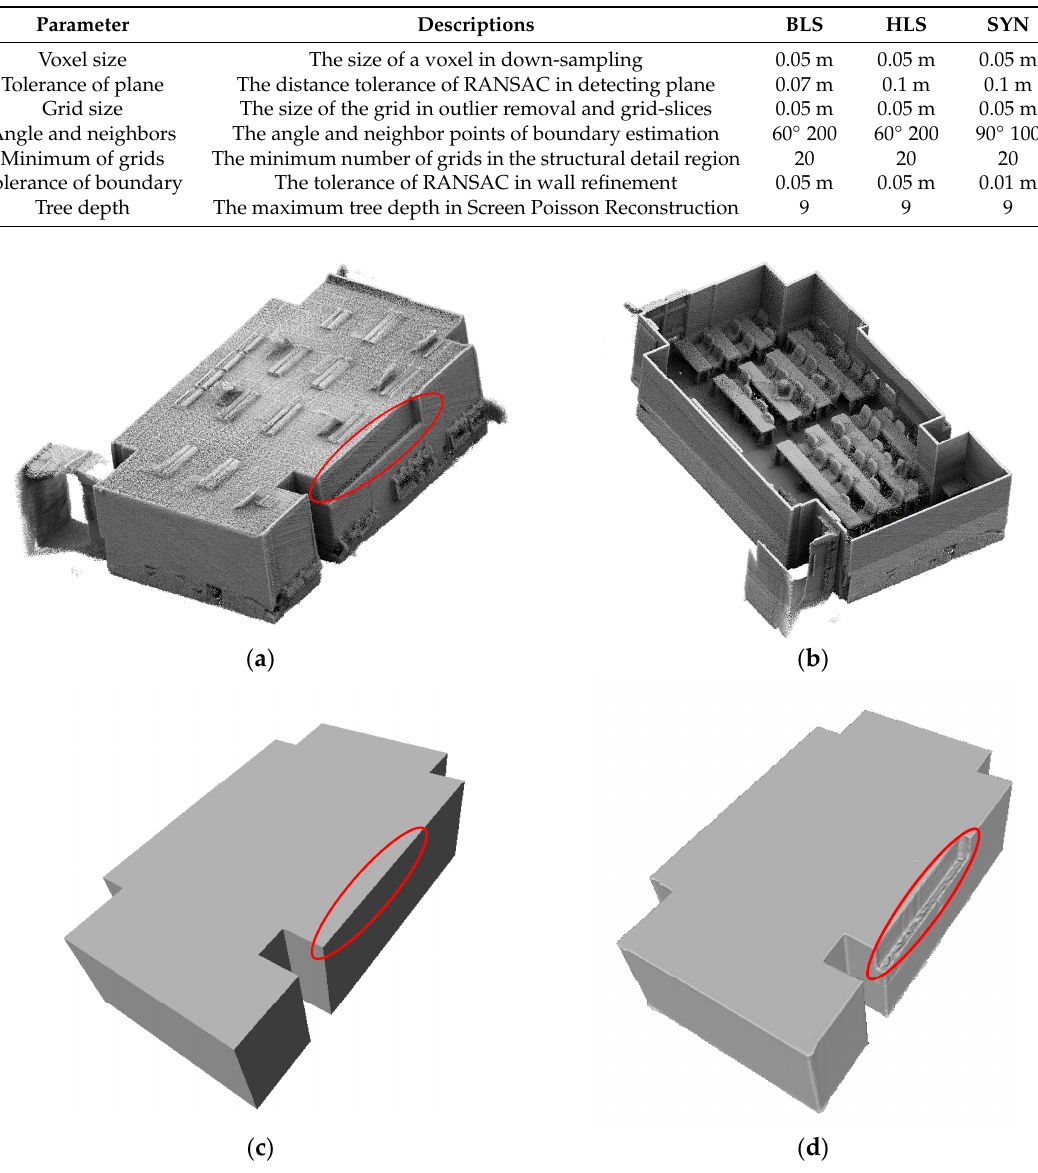
Table 1. List of main parameters involved in the proposed approach and values in experiments.